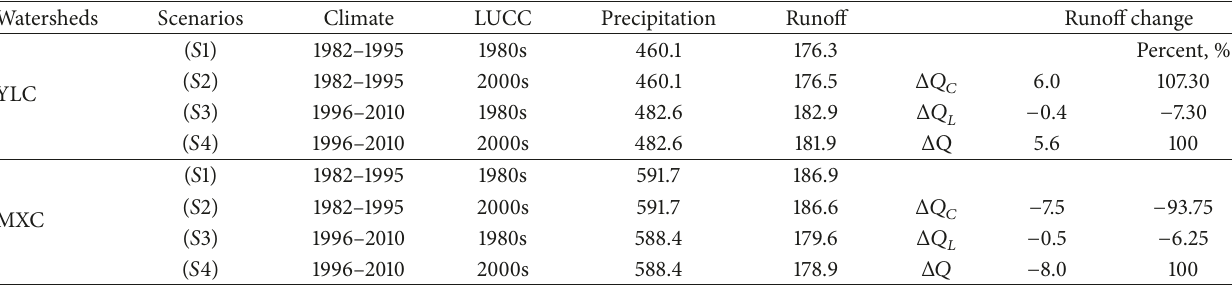
Table 3: Simulated annual runoff for different climate and land uses scenarios in YLC and MXC (mm). Delta 𝑄 𝐶 = average of ( 𝑆3 − 𝑆1 ) + Percent% delta 𝑄 𝐿 = delta 𝑄𝐿 /delta 𝑄 × 100